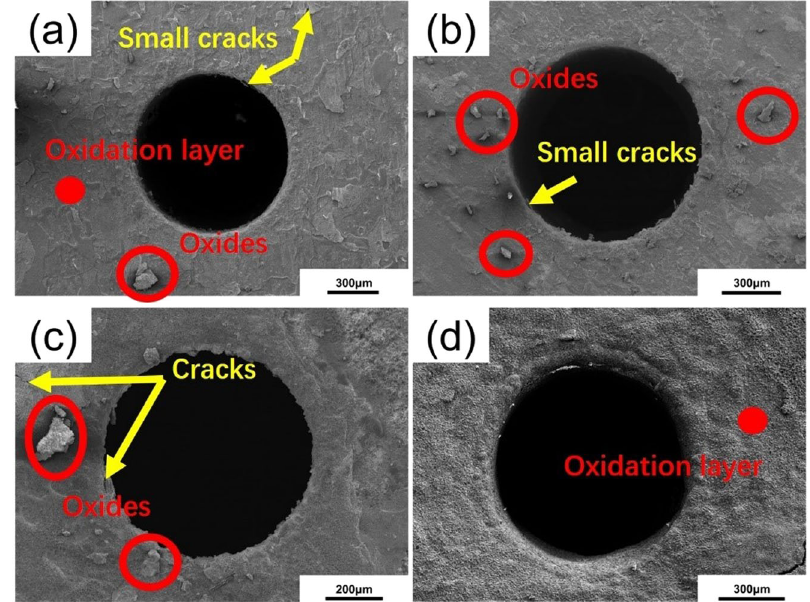
Fig. 6 The surface morphologies around the hole after hot corrosion at 900 °C. a 20 h, b 50 h, c 100 h, and d 200 for some spallation of the surface oxides and a slight increase in the thickness of the reaction layer around the hole increases the internal products. When the hot corrosion continues and signi fi cantly with the extension of reaction time. Second, the top reaches 100 h, the microstructure around the hole has undergone layer of loose oxide is consumed, but at the same time, a relatively relatively dramatic changes, which can be seen in Fig. 7e, f. First, dense layer of Al 2 O 3 is quietly formed beneath it. Third, hot